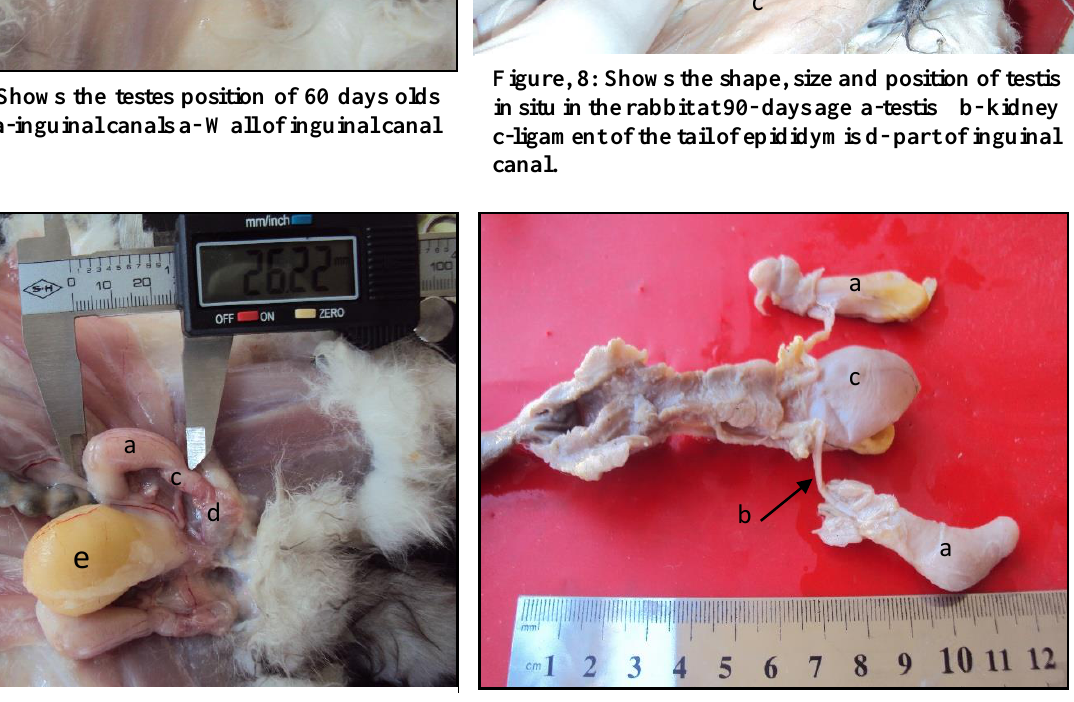
Figure, 10: Reproductive organs of the Buck rabbit at 150 days age, shows the Shape of the testes a- testis b-Ductus deferens c- urinary